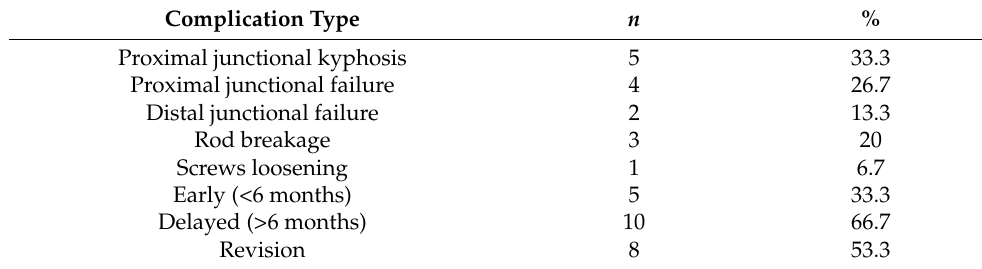
Figure 2. Example of proximal junctional failure. ( A ) Preoperative sagittal X-ray; ( B , C ) 12-month postoperative X-ray and magnetic resonance revealed fracture and sagittal subluxation one vertebra above upper instrumented vertebra; ( D ) X-ray after revision surgery. Complications occurred within 6 months after surgery in five patients (33.3%). Eight patients (53.3%) out of the 15 patients who experienced a mechanical complication underwent revision surgery (Table 1). Table 1. Mechanical